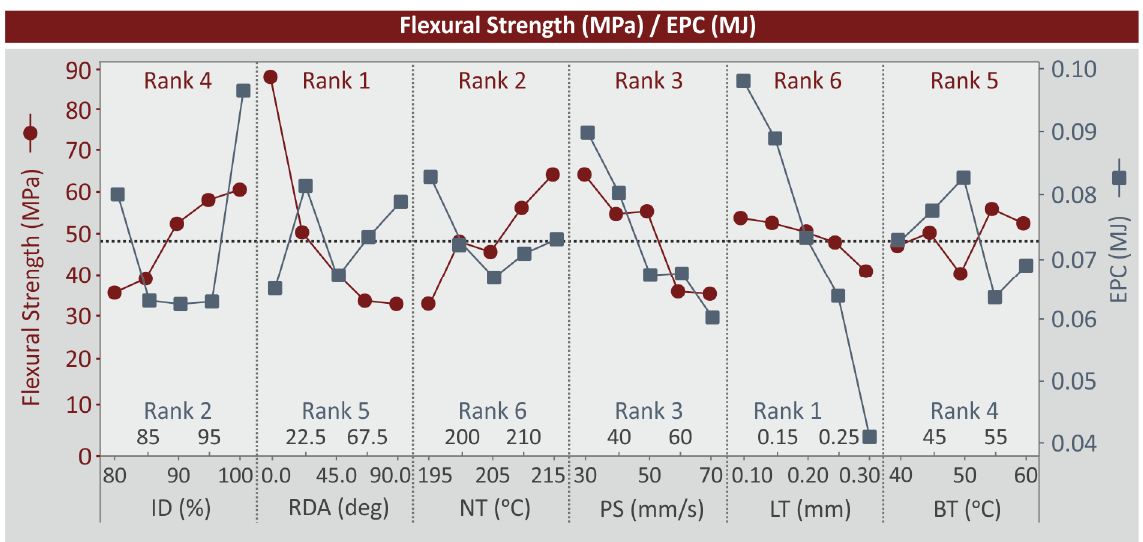
Figure 8. MEP: flexural strength (MPa), EPC (MJ).